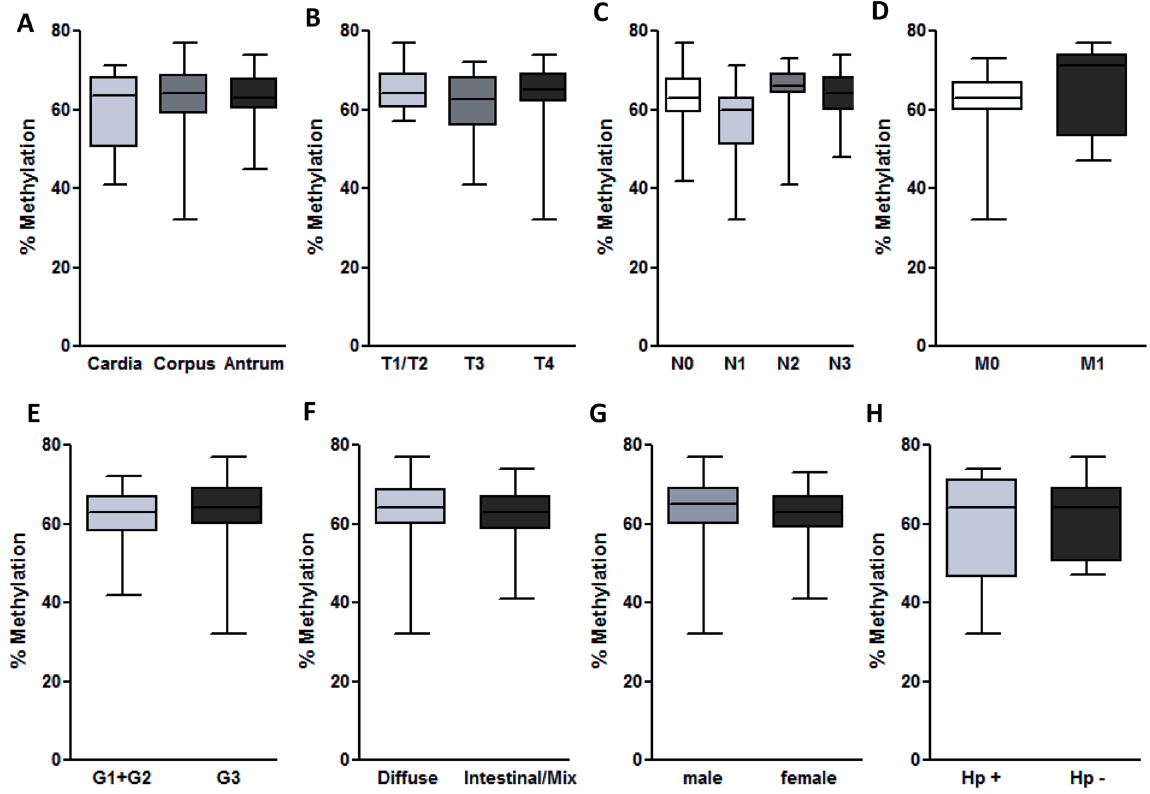
Figure 4. Subgroup analyses of LINE-1 methylation in gastric cancer patients according to clinicopathological data. LINE-1 methylation analyses based on ( A ) anatomical tumour localization (p = 0.41), ( B ) T- (p = 0.20), ( C ) N-, (p = 0.11) and ( D ) M-tumor staging (p = 0.17). ( E ) LINE-1 methylation differences in patients with low and high-grade tumors (p = 0.26). LINE-1 methylation differences in GC patients according to ( F ) Lauren’s classification of GC type (p = 0.39), ( G ) gender (p = 0.83) and ( H ) H . pylori status (p = 0.70). Statistical analyses were performed using Mann-Whitney for two and Kruskal-Wallis test with Dunn’s posttest for multiple comparison